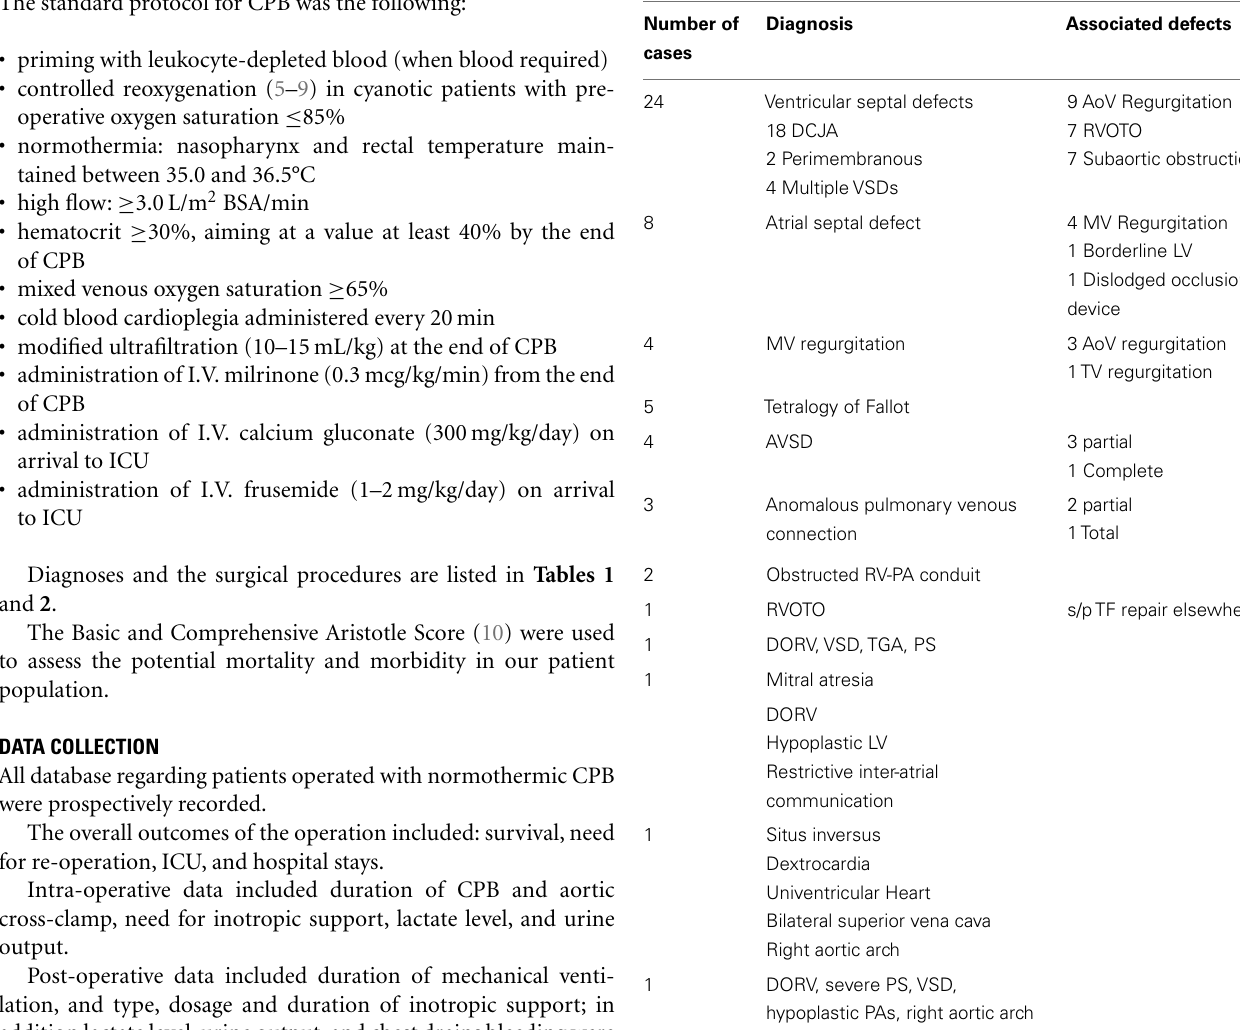
Table 1 | List of diagnosis and associated defects